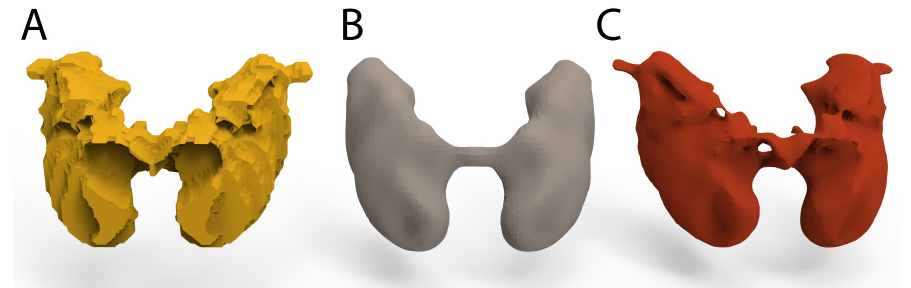
Figure 4. Smoothing process applied on the Basal Ganglia: ( A ) Basal ganglia before being smoothed; ( B ) smoothing process with Amira 3D software; and ( C ) smoothing process with Unigraphics NX. The joins were added with a 5% tolerance to facilitate attach and detach parts after being 3D